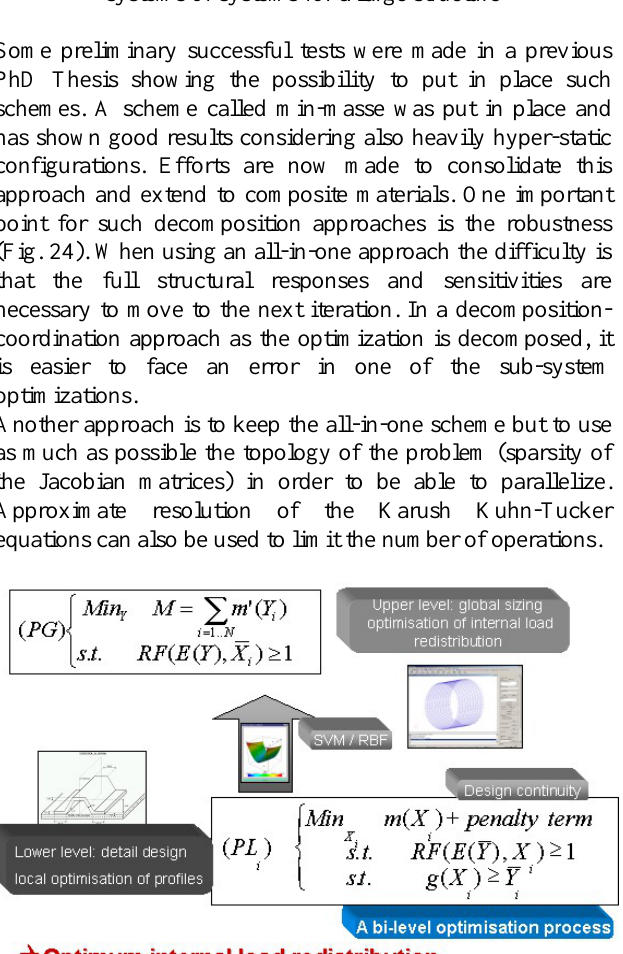
Fig. 23. Multi-level optimization applied to optimization of